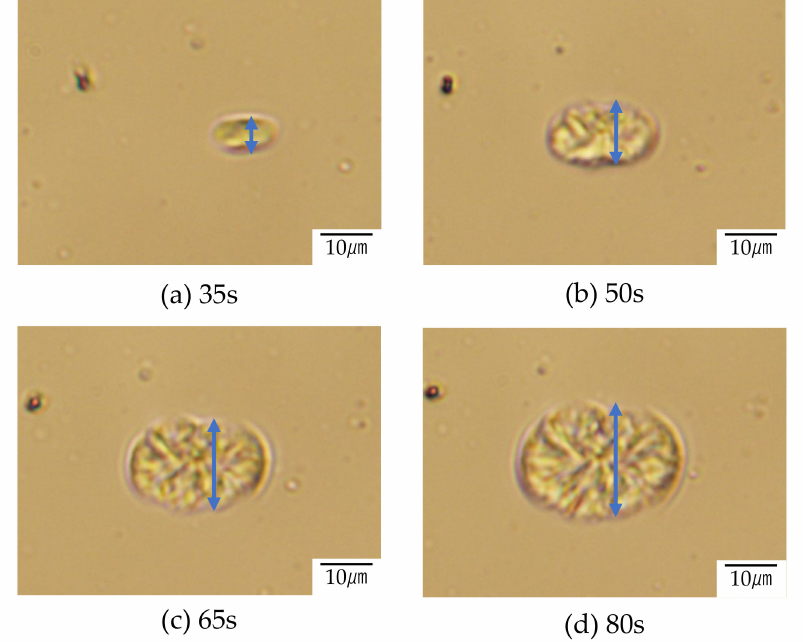
Figure 10. Structure development of neat PTT during the crystallization at 210 ◦ C after ( a ) 35 s, ( b ) 50 s, ( c ) 65 s and ( d ) 80 s observed by optical